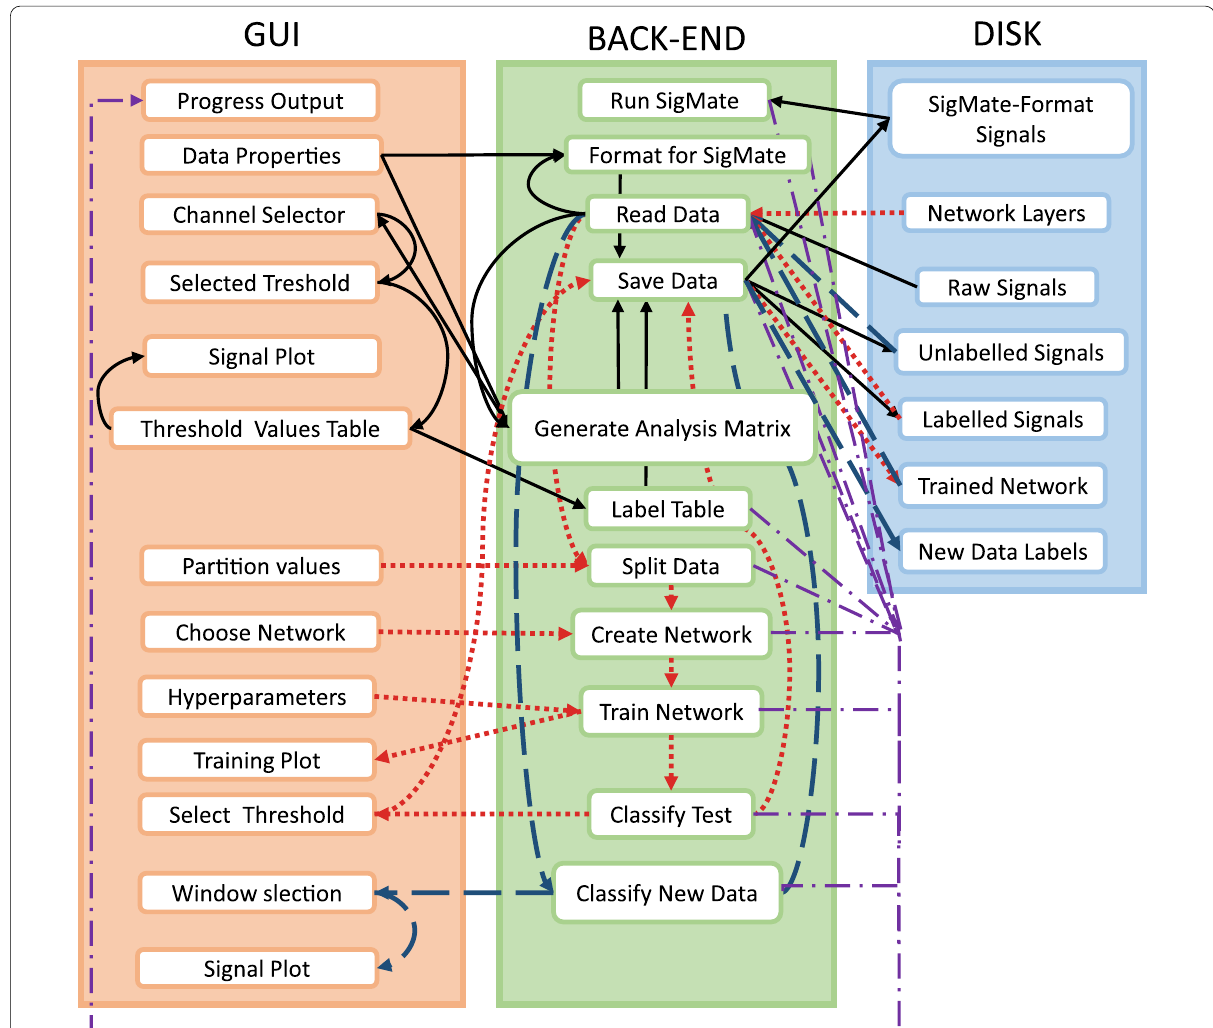
Fig. 5 Functional block diagram of the Toolbox.Arrows in black correspond to the “Data Labeling” module , in red to the “Neural Network Training” module, in dark blue to the “Classify New Unlabeled Data” module, and the purple arrows indicate the progress